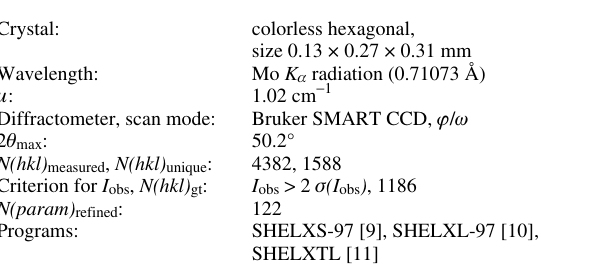
Table 1. Data collection and